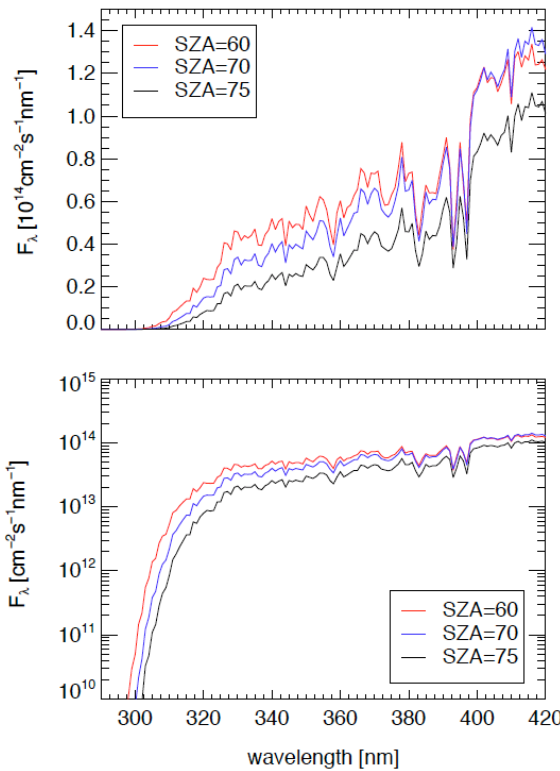
Fig. 1. Three examples of SAPHIR actinic flux spectra for differ- Figure 1: Three examples of SAPHIR actinic flux spectra for different solar zenith ent solar zenith angles (SZA) measured during Experiment 3. Top: linear y-axis scale, bottom: logarithmic y-axis angles (SZA) measured during experiment 3. Top: linear y-axis scale, bottom: logarithmic y-axis scale.